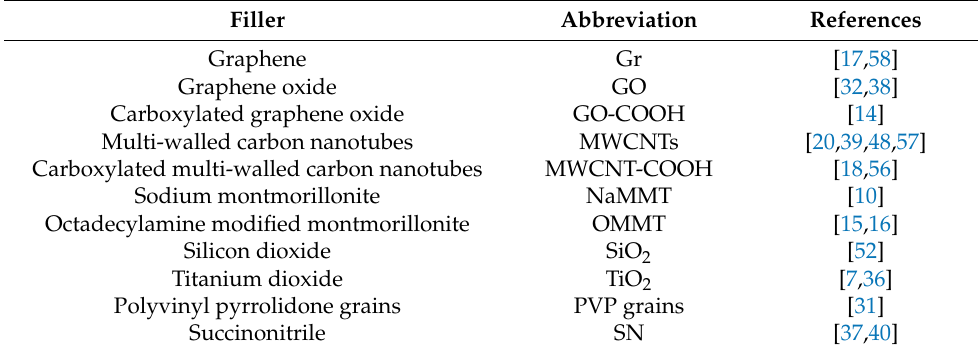
Table 3. Examples of fillers modified with imidazolium-based ionic liquids for preparation of PVDF and PVDF-HFP composites. Filler